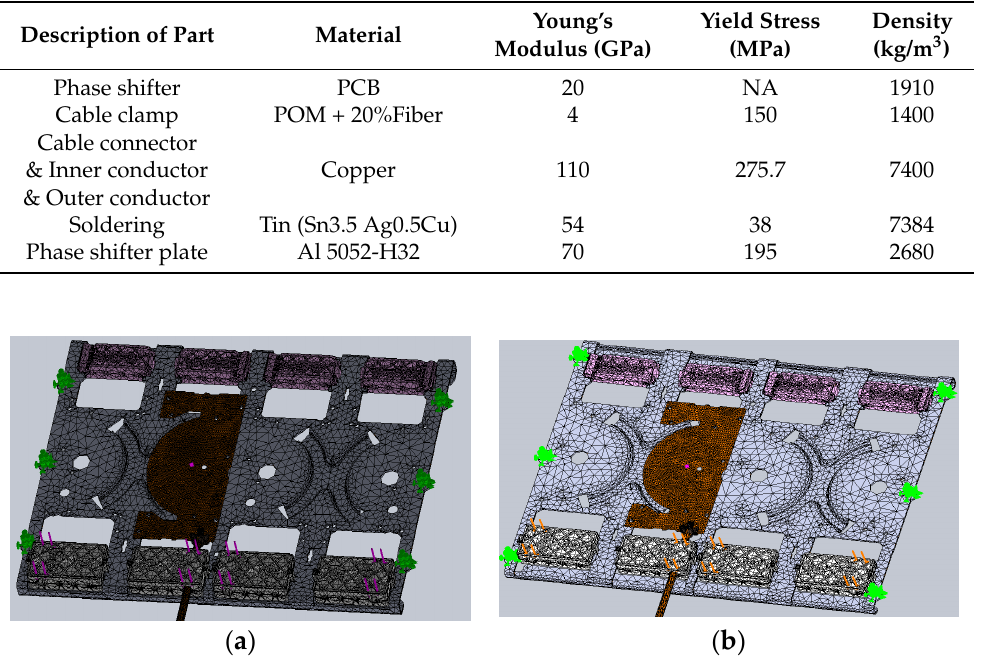
Figure 13. The deformation at the first-order natural frequency. Table 3. Setting of the mechanical performance of materials.